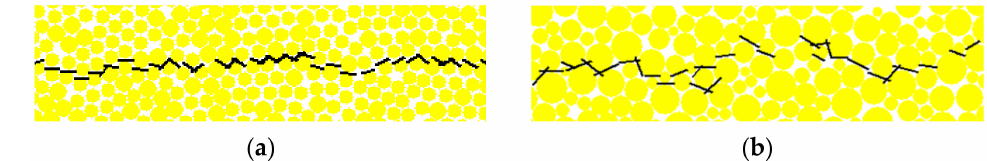
Figure 11. Effect of grain size heterogeneity on microcracks: ( a ) grain size homogeneous model ( R max /R min = 1.2) and ( b ) grain size heterogeneous model ( R max /R min = 3.0).